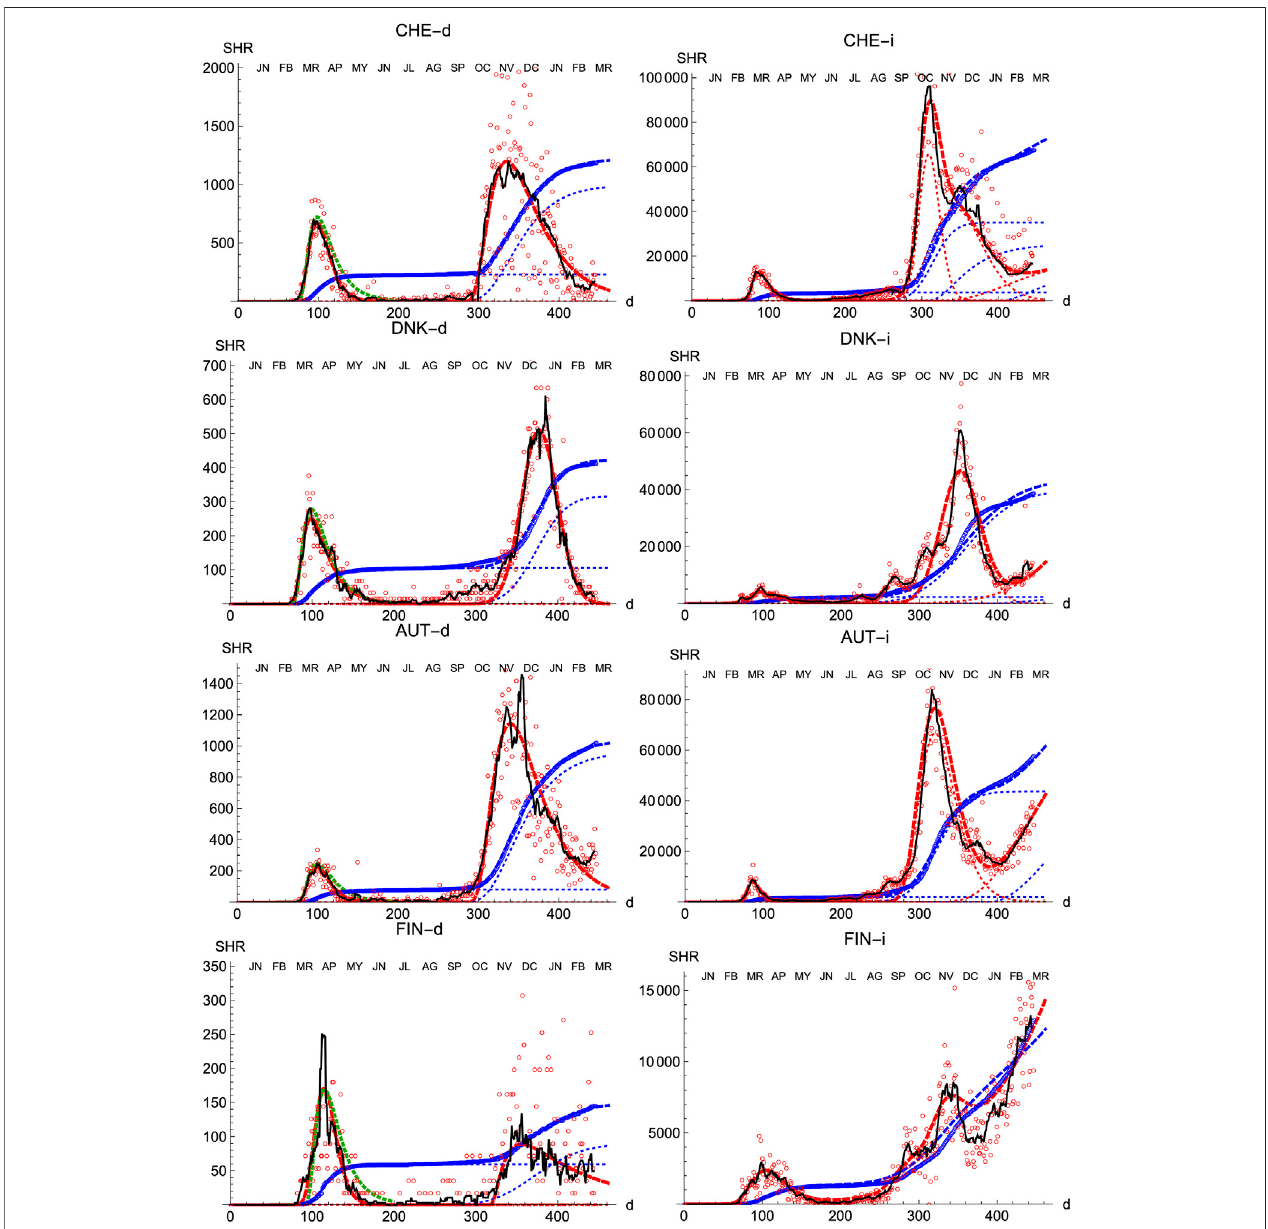
FIGURE 4 | SHR/Other countries (II). Symbols as in Figure 1